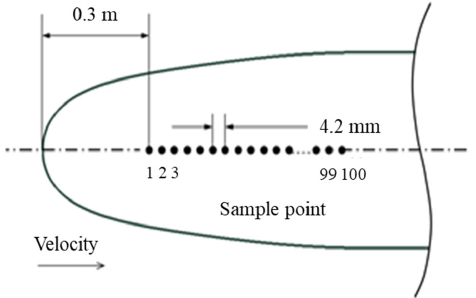
Figure 18. The position of the sample points.